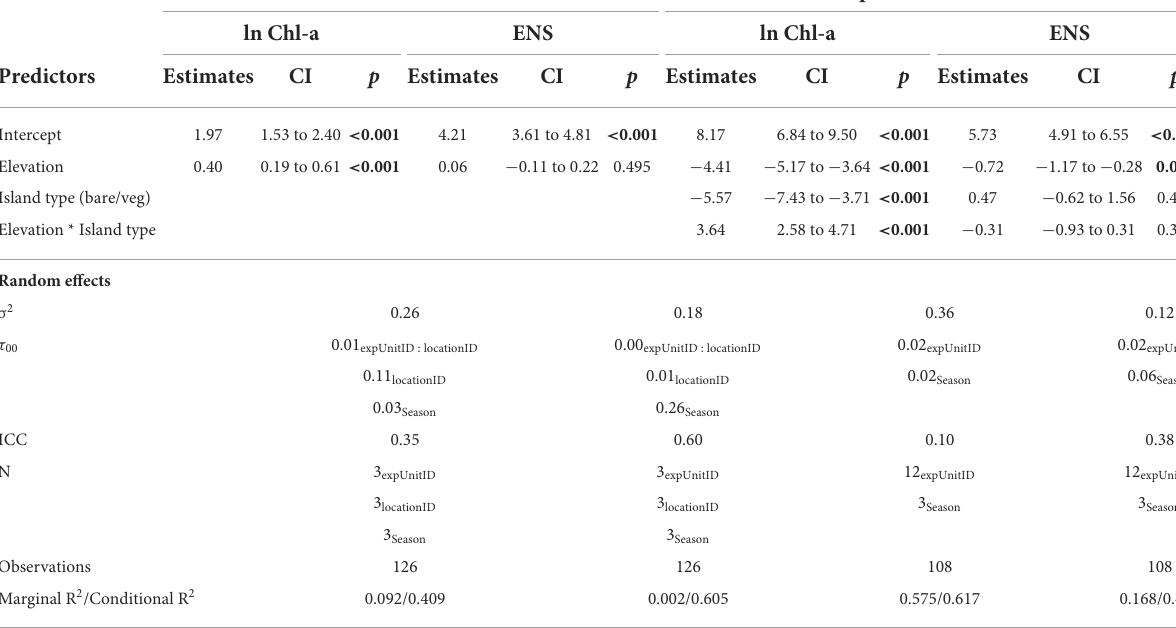
TABLE 1 Linear mixed-effects model (LMM) output from the analysis of the response